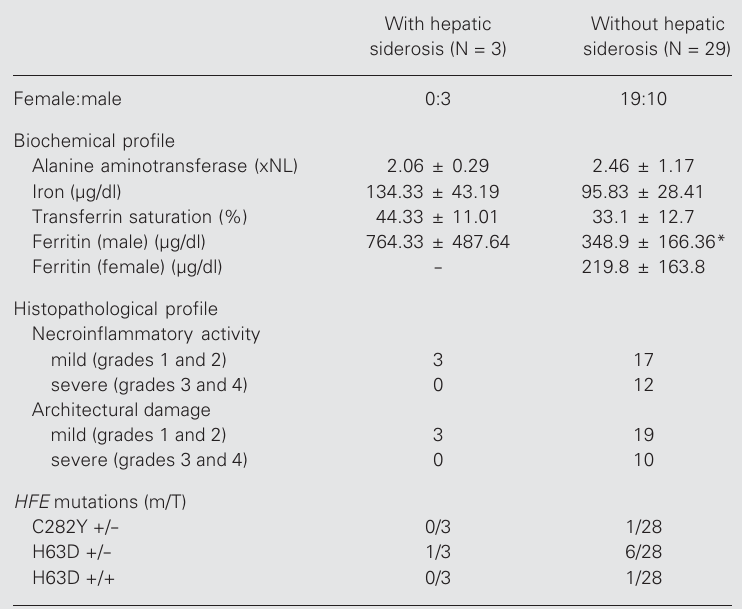
Table 2. Biochemical, histopathological and HFE mutational results of patients with and without hepatic siderosis. With hepatic Without hepatic siderosis (N = 3) siderosis (N =